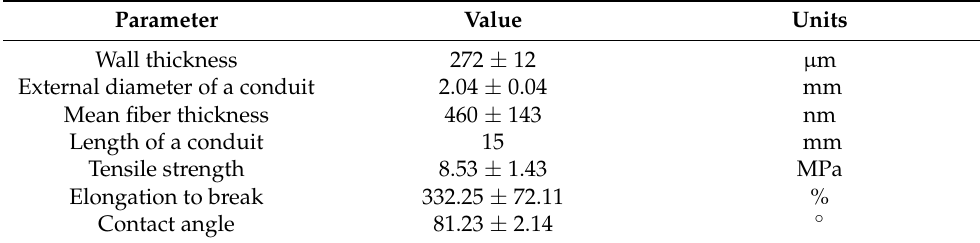
Figure 1. SEM images of electrospun P(LLA-CL)-COL-PANI conduits. ( A ) View into the inner part of a tubular scaffold; ( B ) Magnification on the structure of the scaffold. Table 1. Parameters of P(LLA-CL)-COL-PANI conduits.